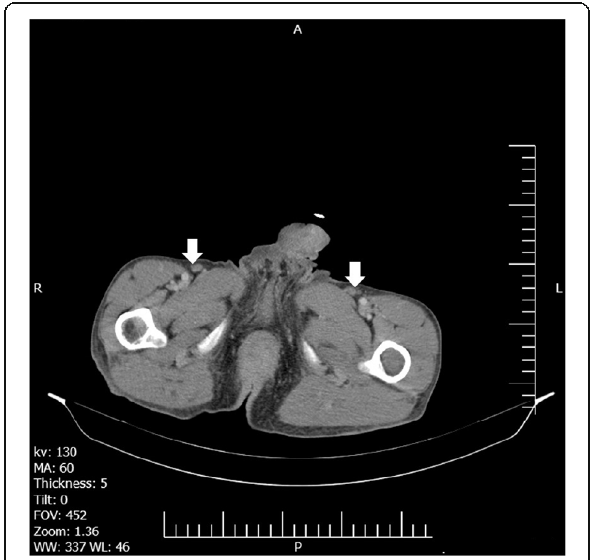
Fig. 5 Bilateral inguinal lymphadenopathy showed by the